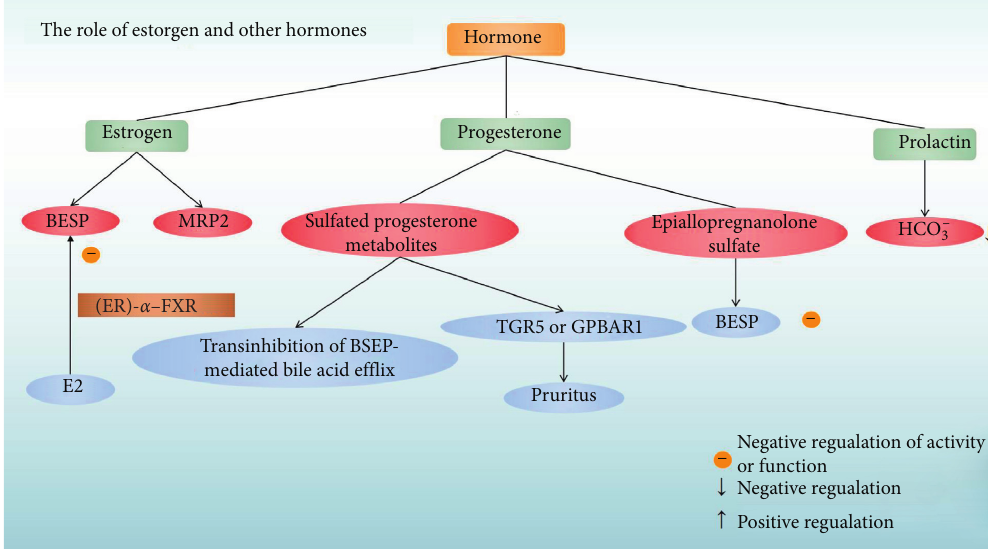
Figure 2: The role of hormones in the pathogenesis of ICP. Estrogen can regulate two proteins related to bile acid homeostasis, BESP, and MRP2, among which E2 can inhibit BESP through the interaction of ER- α and FXR; the metabolism of sulfated progesterone can activate GPBAR1 or TGR5 and cause transinhibition of BSEP-mediated bile acid efflux. Epiallopregnanolone sulfate can inhibit the expression of BESP. Prolactin can lead to a decrease in the concentration of bicarbonate in the blood. Adjustment events are displayed with